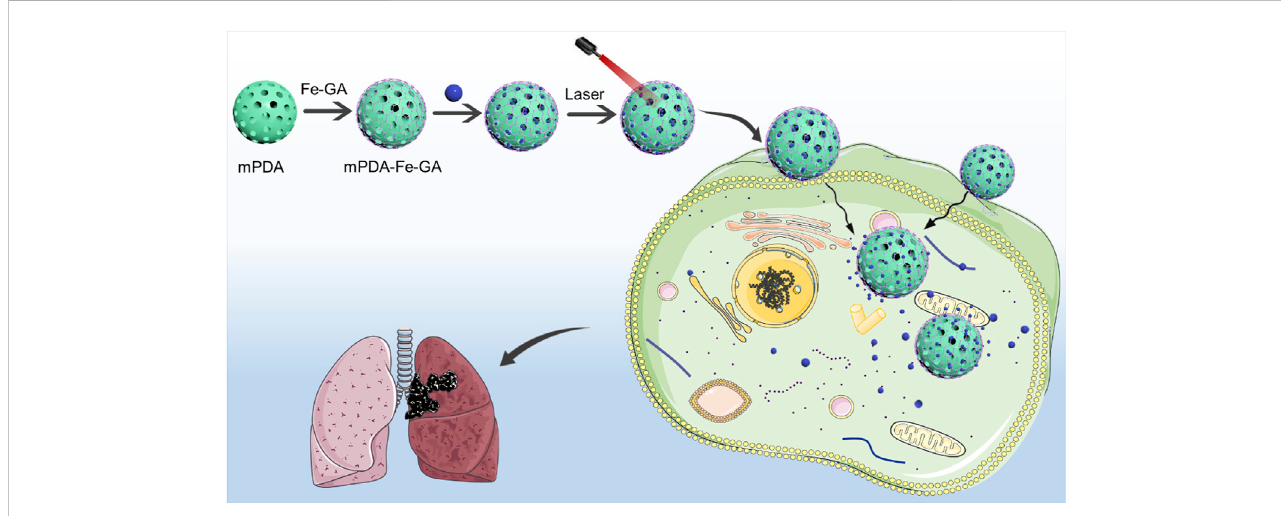
FIGURE 1 The preparation process and schematic diagram of PTX@mPDA@Fe-GA. PTX, paclitaxel; mPDA, mesoporous polydopamine; Fe-GA, Fe-gallic